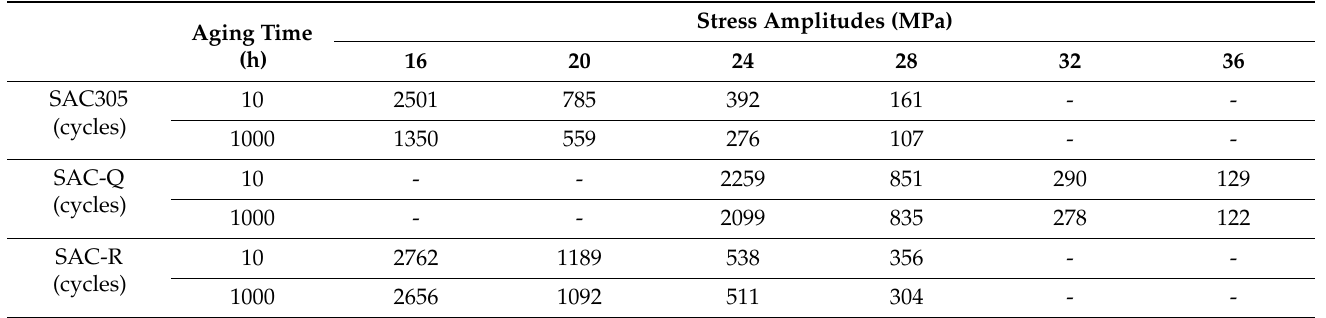
Table 5. Characteristic life (cycles) of aged individual solder joints.